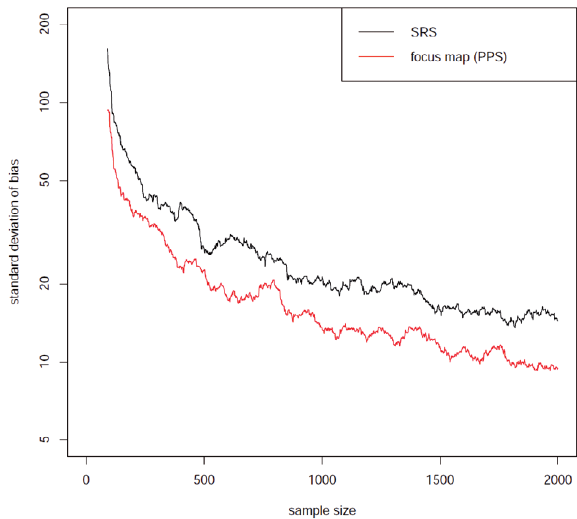
Figure 6. Standard deviation of the bias computed for the two dif- ferent sampling approaches: PPS based on focus maps and SRS. The standard deviation is computed over a running buffer with 90 point, and refers to samples of increasing size. The PPS approach has a lower bias with respect to the purely random one.